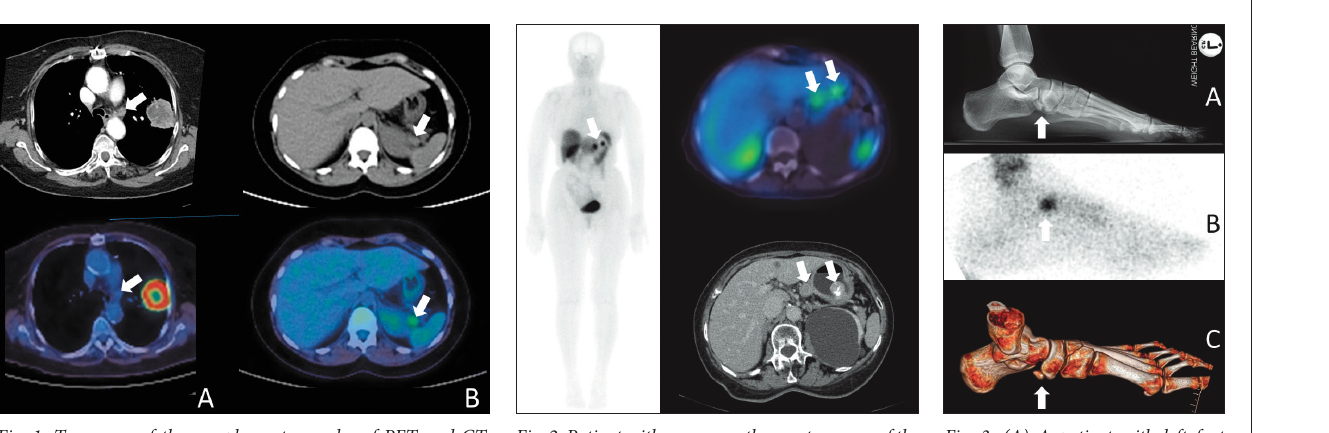
Fig. 1. Two cases of the complementary roles of PET and CT, showing (A) an enlarged lymph node identified on CT in a patient with lung cancer negative on PET/CT, and (B) Hodgkin’s disease in a patient with involvement of multiple lymph nodes above the diaphragm in which PET identified involvement of a single node in the splenic hilum.